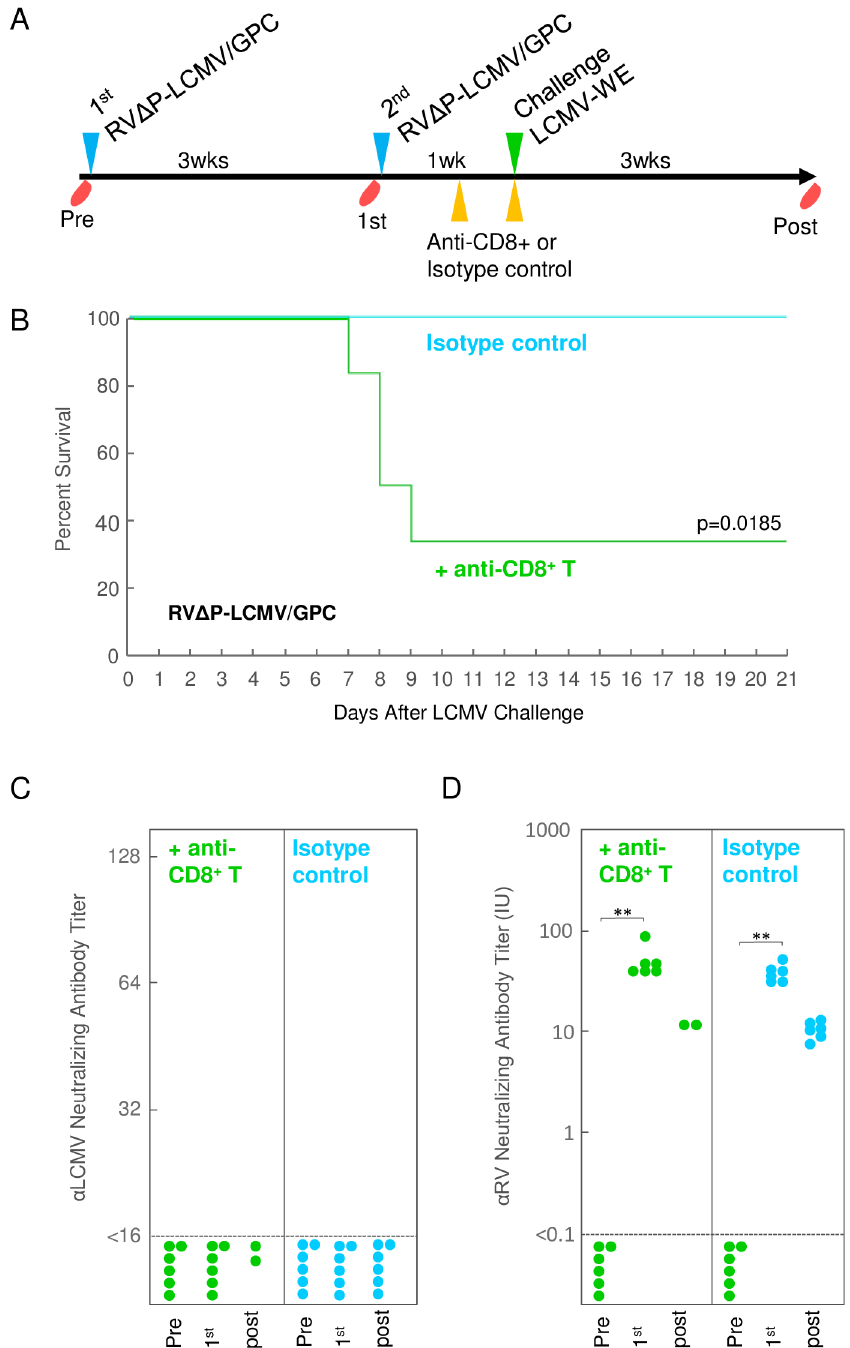
Fig 6. Survival curves and NAb titers in mice infected with LCMV-WE with or without CD8+ T cell depletion. (A) RV Δ P-LCMV/GPC inoculation, challenge, and blood collection schedules in C57BL/6 mice. Mice were inoculated with RV Δ P-LCMV/GPC twice at 3-week intervals. Mice were injected with anti-CD8+ T cell antibody (n = 6) or Isotype control (n = 6) 4 days and 7 days after the last RV Δ P-LCMV/GPC inoculation. Seven days after the last inoculation, mice were intracranially infected with 10 PFU of LCMV-WE. Mouse serum was collected 1 day before the first RV inoculation (Pre) and second RV inoculation (1st), and the serum of the surviving mice was collected on the last day of the 3-week observation (Post). (B) The survival curve of mice injected with CD8+ T cell antibody or isotype control. The titers of anti-LCMV (C) and anti-RV (D) NAb in mice with and without CD8+ T-cell